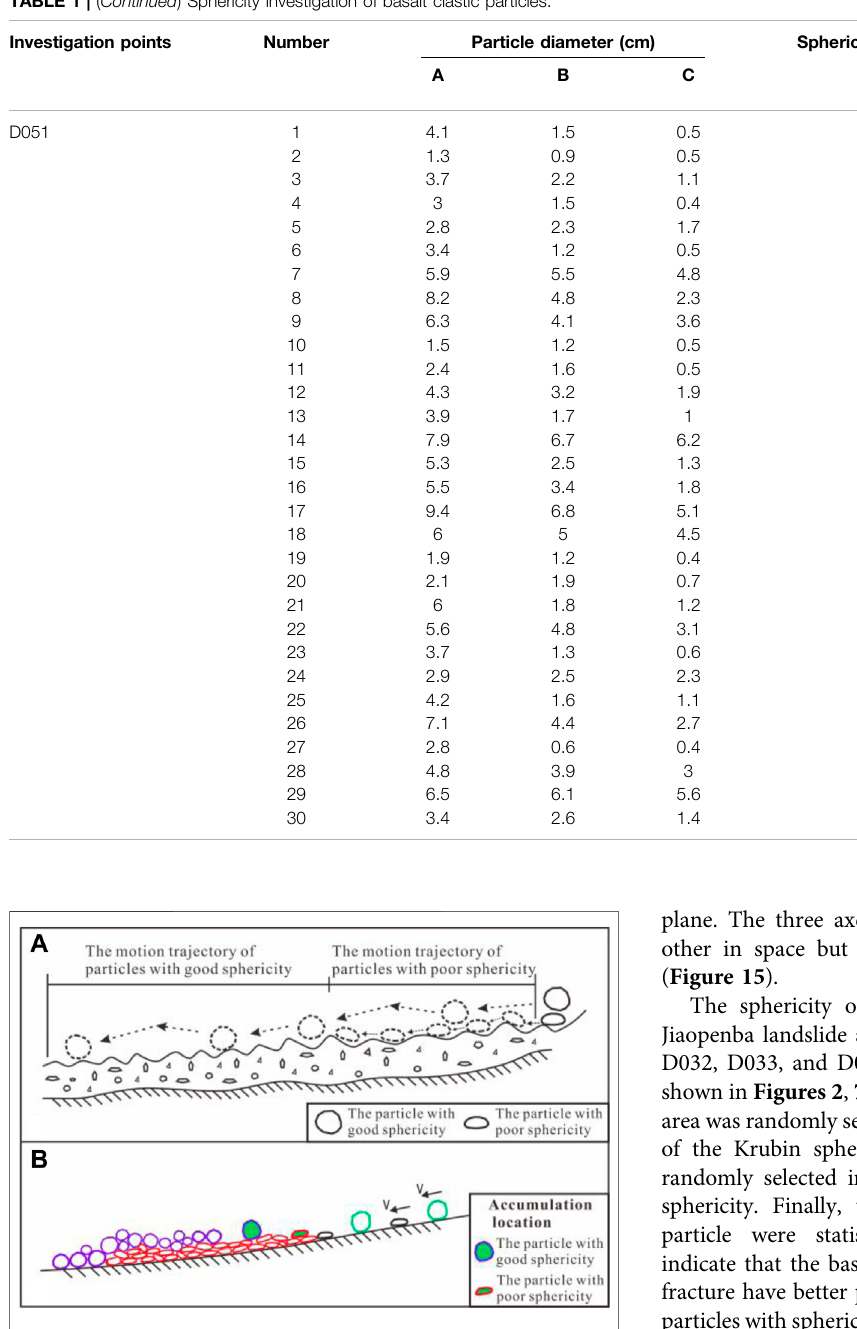
Frontiers in Earth Science |